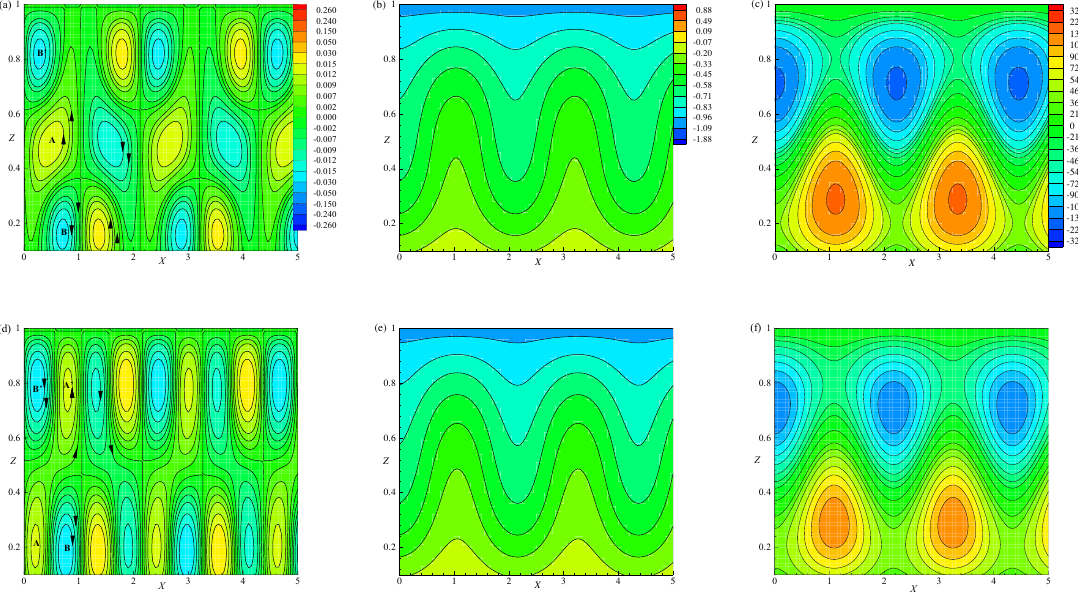
Figure 12. Streamlines ( left ), isotherms ( middle ) and isoconcentration lines ( right ) for t = 1.1 ( a – c ) and 0.2 ( d – f ) for Le = 0.06, ψ = − 0.01, t = 0.1, R = 3 R co